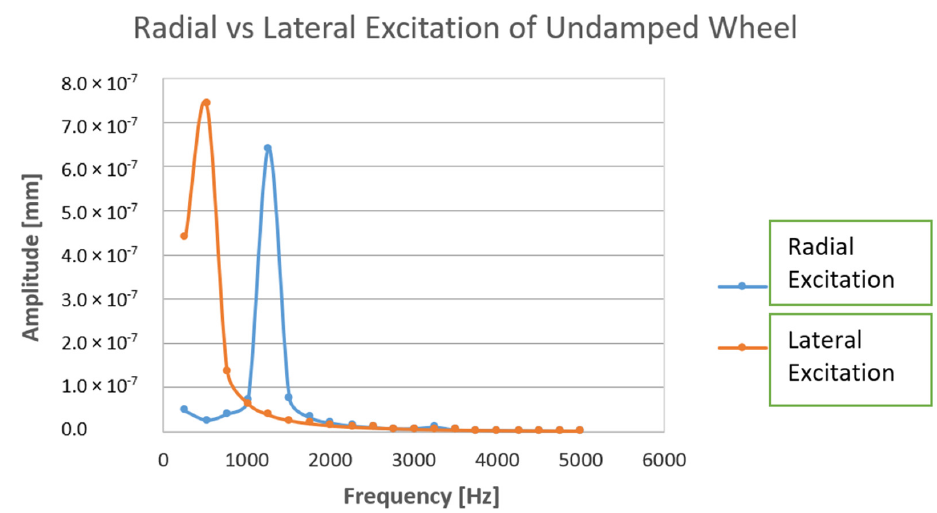
Figure 12. Comparison of the radial and lateral harmonic responses of the wheel.